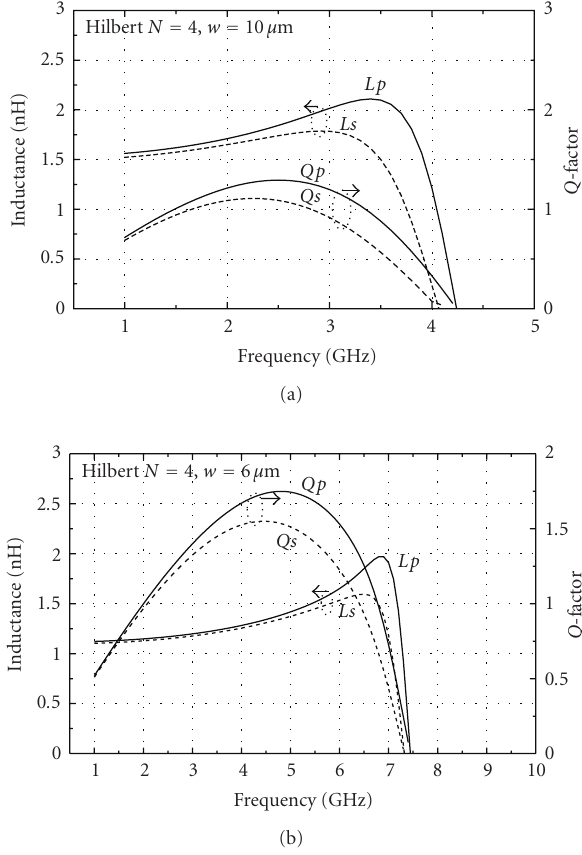
Figure 9: Frequency characteristics of the inductance and quality factor of integrated stacked transformer realized with 4th order of Hilbert curve (a) w p = w s = 10 μ m, (b) w p = w s = 6 μ